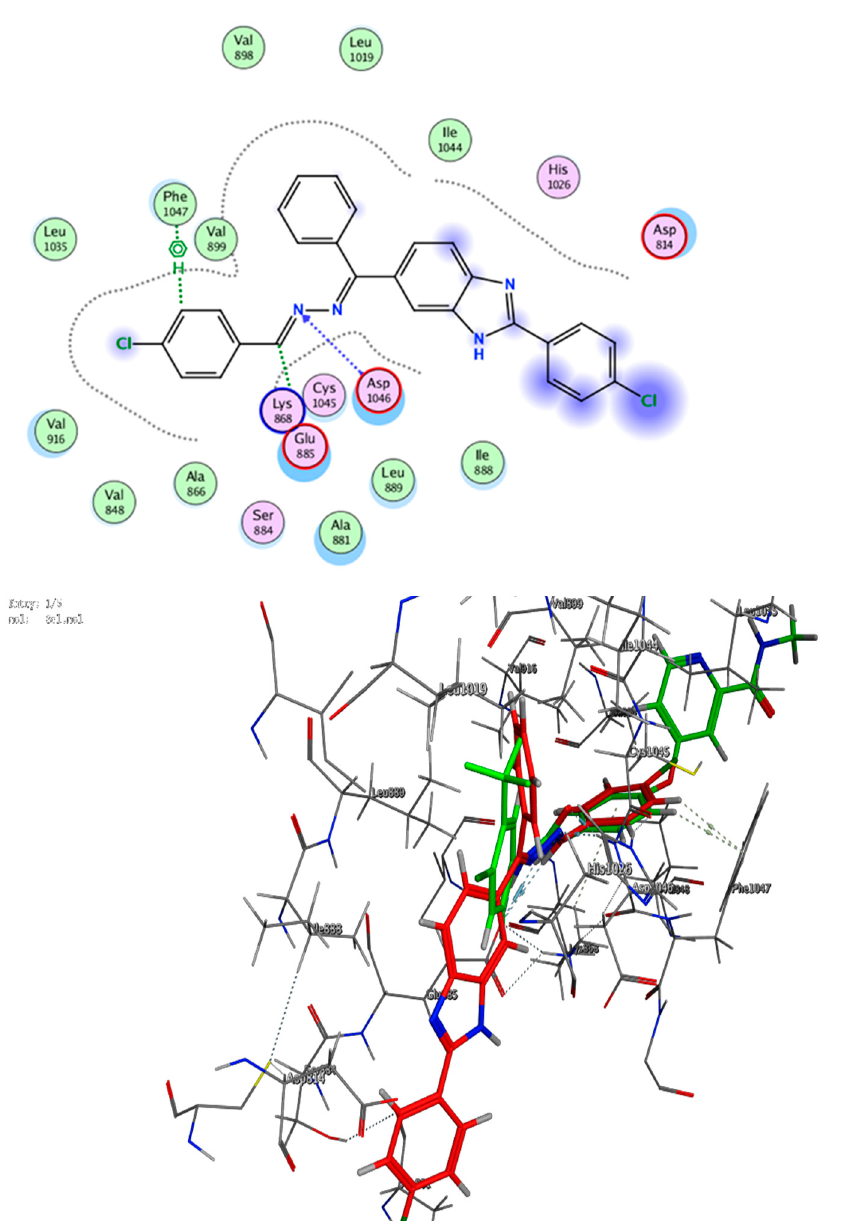
Figure 6. Two-dimensional and three-dimensional models of the binding of 3g with the active site of VEGFR-2.